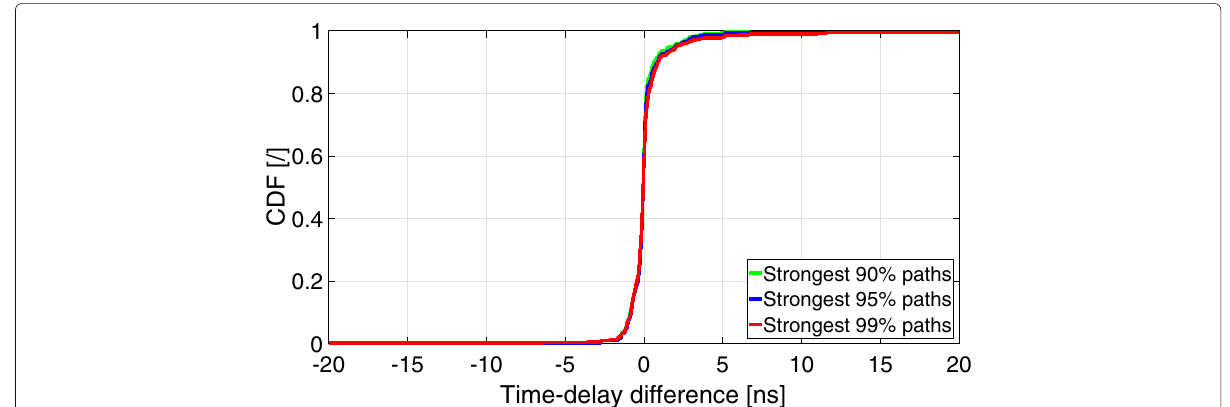
Fig. 7 CDF of the ToA differences between the input and output strongest 90, 95, and 99% propagation paths